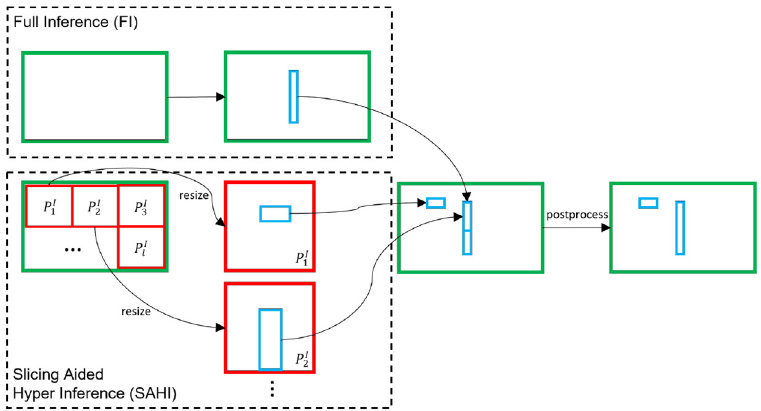
Figure 7. The process of slicing aided hyper inference.